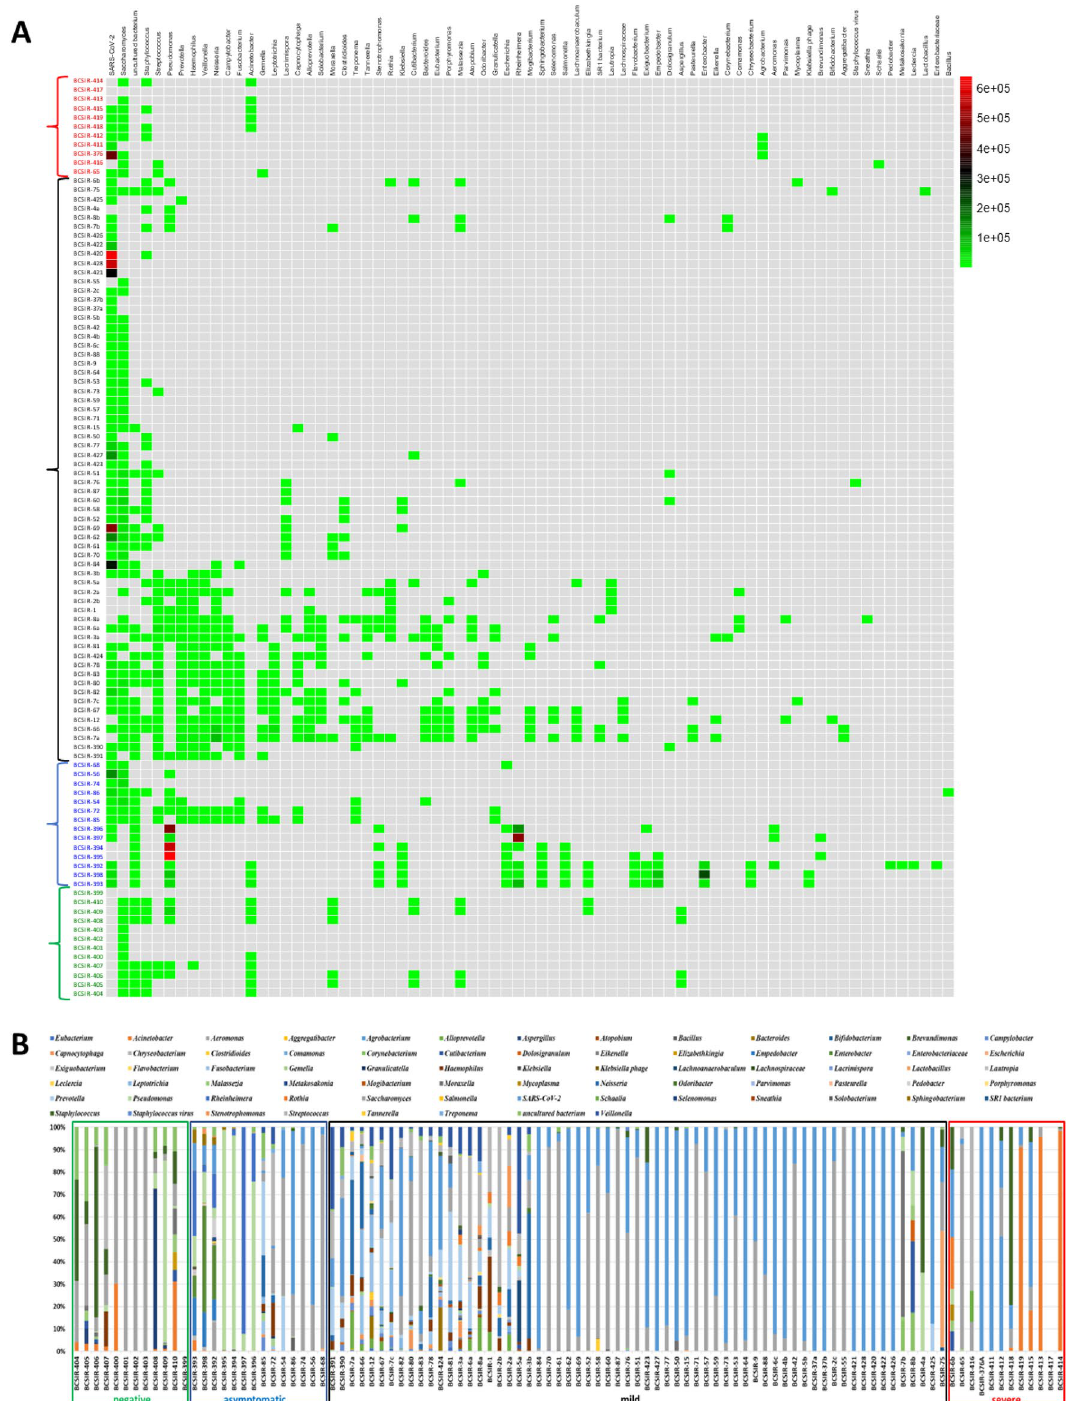
Figure 4. Taxa identified within nasopharyngeal swabs by genera. ( A ) Heatmap indicating sequencing read depths. The heat map was based on the NT rPM values and generated using pheatmap version 1.0.12. The colour coding and range of NT-rPM is indicated to the right side of heatmap. ( B ) Stacked plot of genera. Data was analysed and charts produced in Microsoft Excel version 2212. Cohorts are indicated by the colored sample names (panel A) or boxes (panel B): green, Negative for SARS-CoV-2; blue, Asymptomatic; black, Mild disease; red, Severe